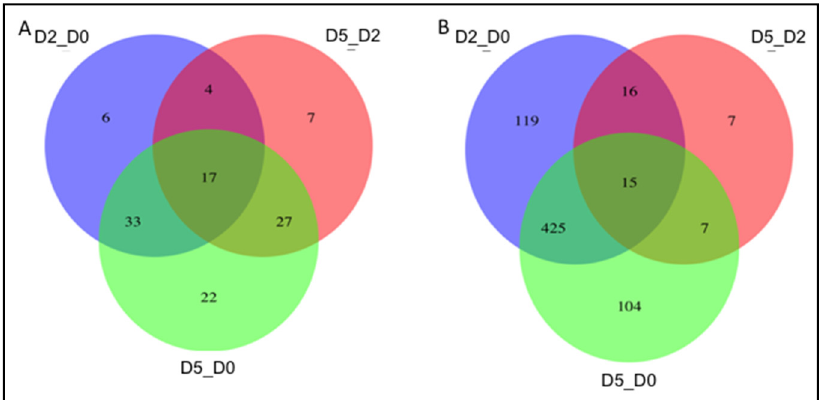
Figure 1. Differentially expressed ( A ) miRNA and ( B ) mRNA at day 2 vs. day 0 (D2_D0, myoblast to early myocyte), day 5 vs. day 0 (D5_D0, myoblast to mature myocyte), and day 5 vs. day 2 (D5_D2, early myocyte to mature myocyte).